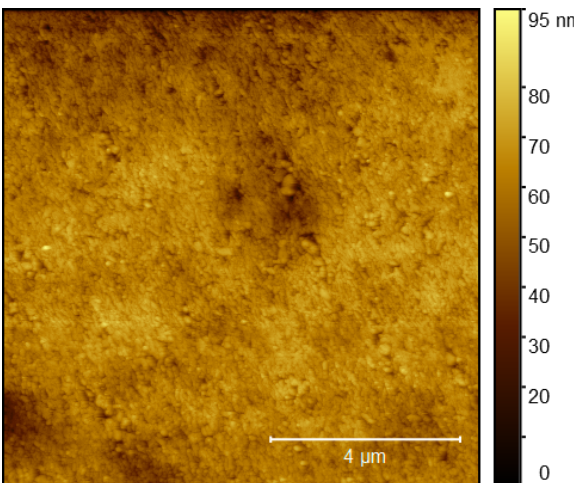
Figure 7. Representative topography image of the magnetic tape taken in vacuum and in dynamic mode for best resolution, whereas AFM images with the SHPM sensor are recorded in static mode. The image was taken at a different position than the SHPM images shown in Figure